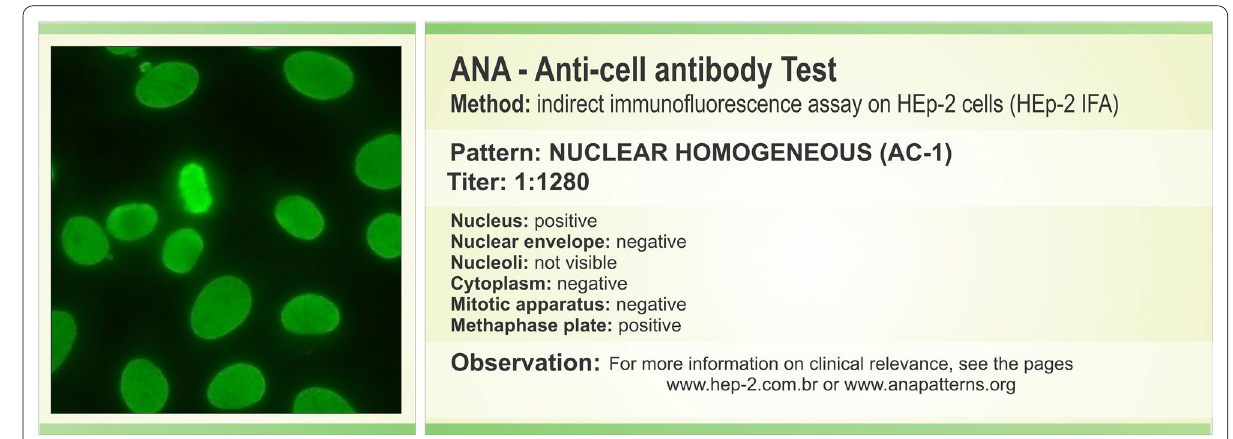
Fig. 5 Example of report based on VI BCA